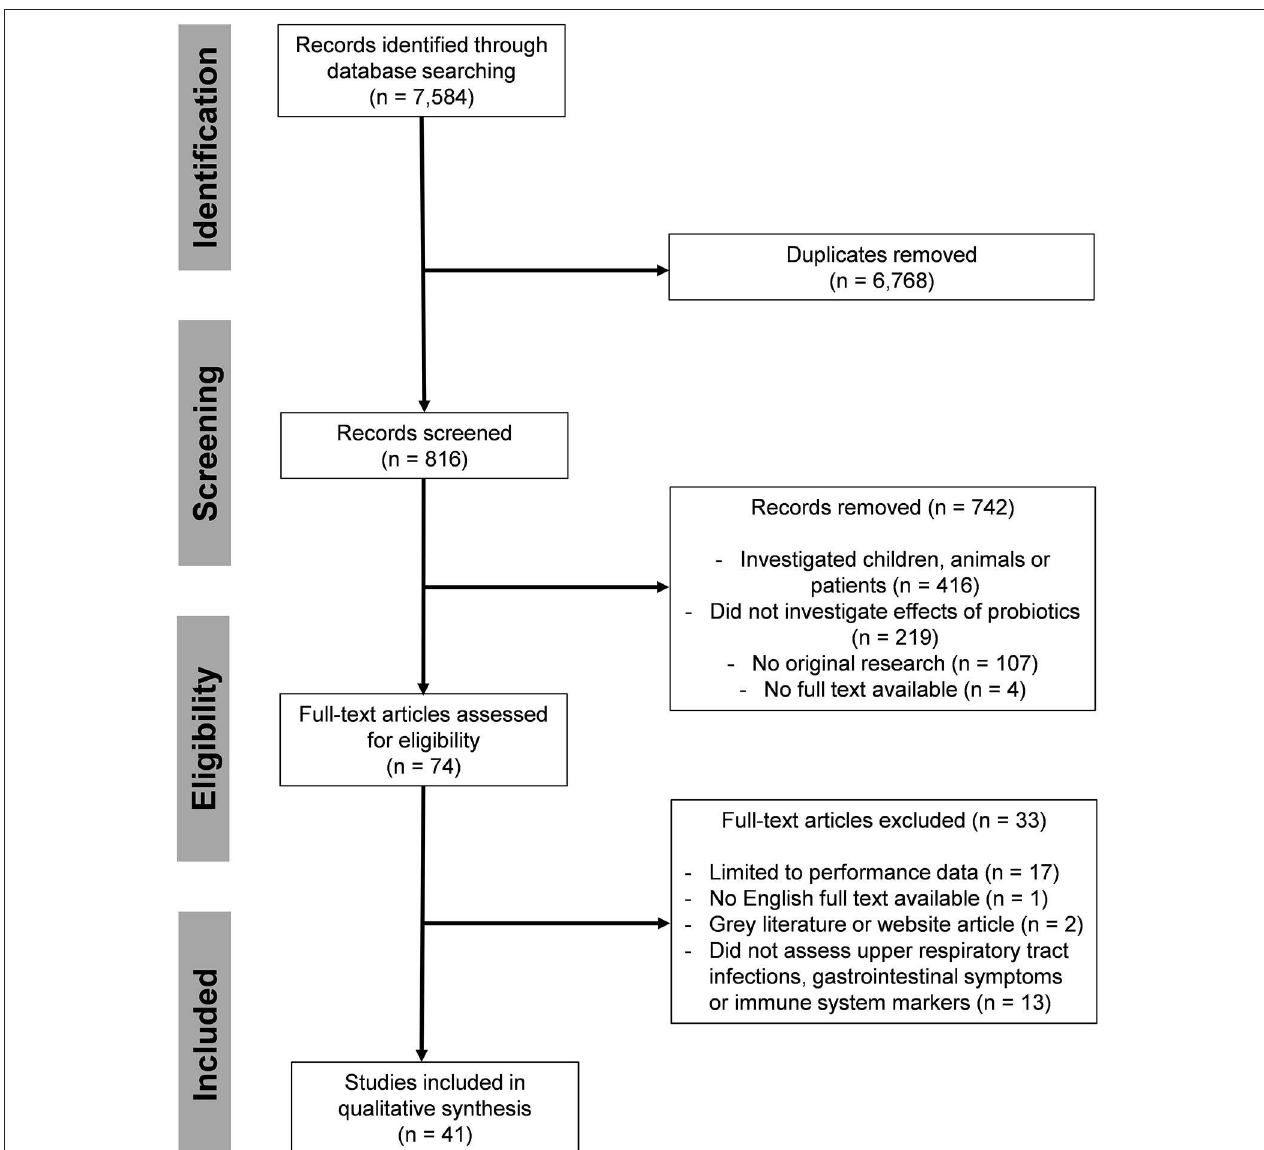
FIGURE 1 | PRISMA flow